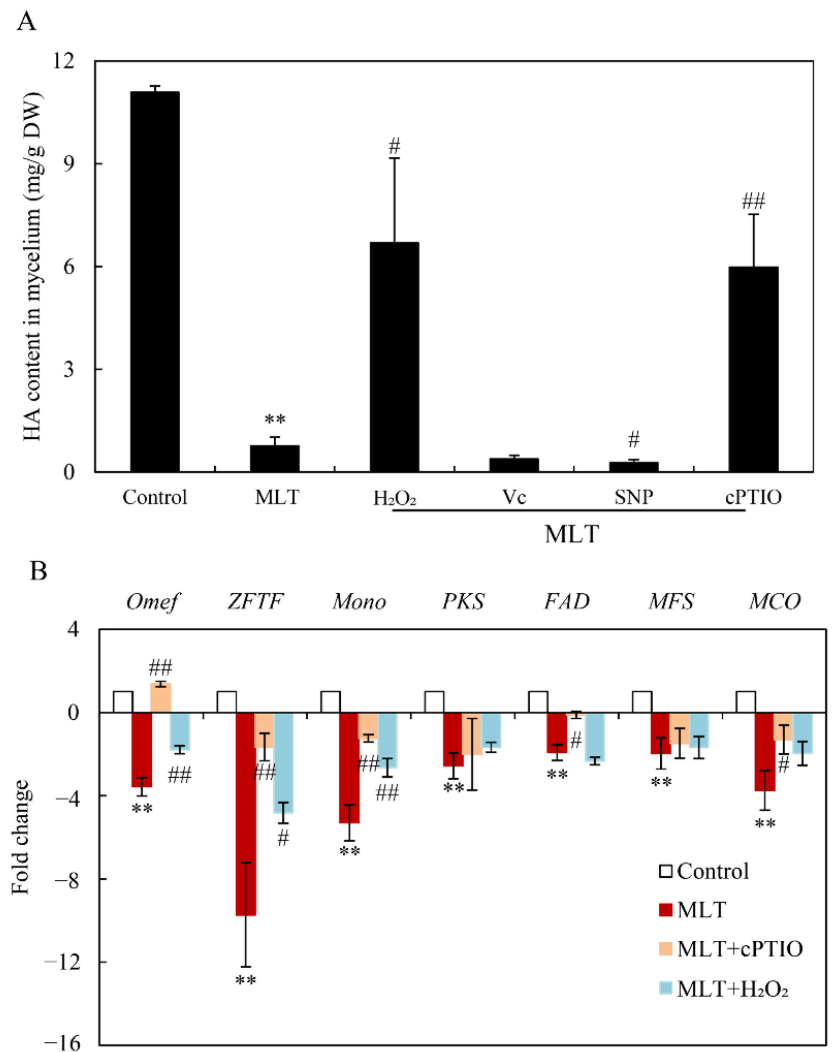
Figure 7. Effects of melatonin (MLT) on HA production ( A ) and the gene expressions ( B ) for HA biosynthesis genes of Shiraia sp. S9. The culture was maintained in a 150 mL flask containing 50 mL medium at 150 r/min and 28 °C under a light/dark shift (24 h: 24h) and harvested on day 8. MLT (100.00 µ M) was added on day 2 of the culture. H 2 O 2 (100 µ M), Vc (10 µ M), SNP (10 µ M) and cPTIO (100 µ M) were added to the culture 30 min prior to MLT treatment. Values are mean ± SD from three independent experiments (** p < 0.01 vs. control, # p < 0.05 and ## p < 0.01 vs. MLT treatment).